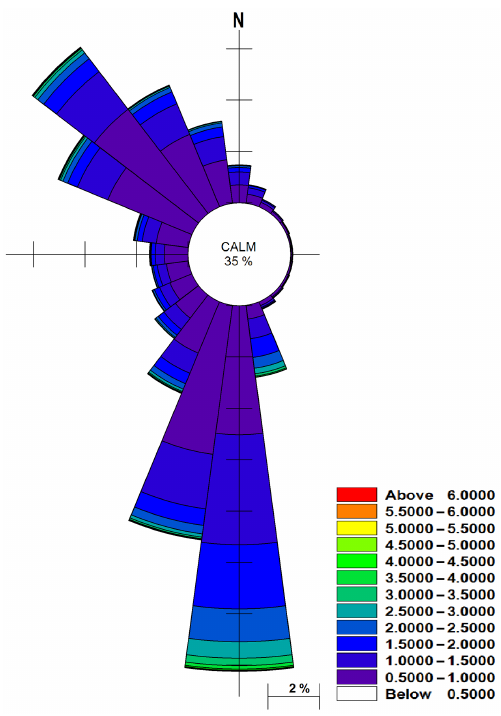
Figure 2. Wave rose at the entrance of Bay of Vlorë (coord. 40 ◦ 30 (cid:48) N, 19 ◦ 12 (cid:48)